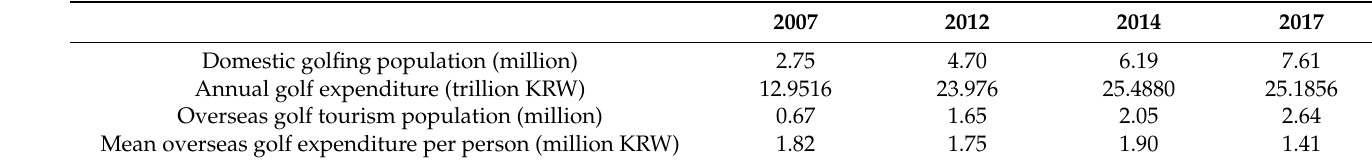
Table 1. Current state of the golfing population.